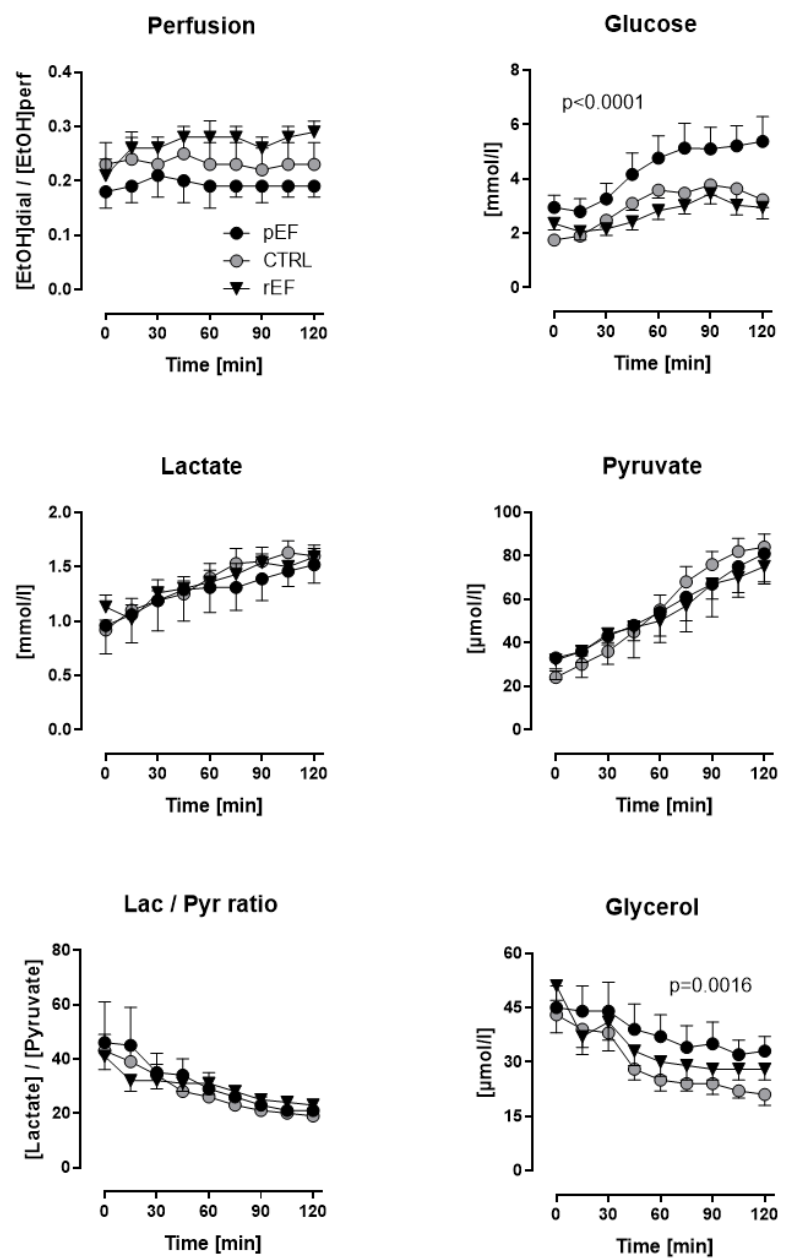
Figure 2. Skeletal muscle ( Vastus lateralis ) ethanol ratio and dialysate concentrations glucose, lactate, pyruvate, and glycerol of patients with heart failure with reduced ejection fraction (rEF, n = 12 men) or patients with preserved ejection fraction (pEF, n = 6 men) and healthy controls (n = 8 men) at baseline and after an oral glucose load (75 g). Data are given as mean ± SE; upper right panel : HFpEF vs. controls, p < 0.0001; lower right panel: HFpEF vs. controls, p = 0.0016.